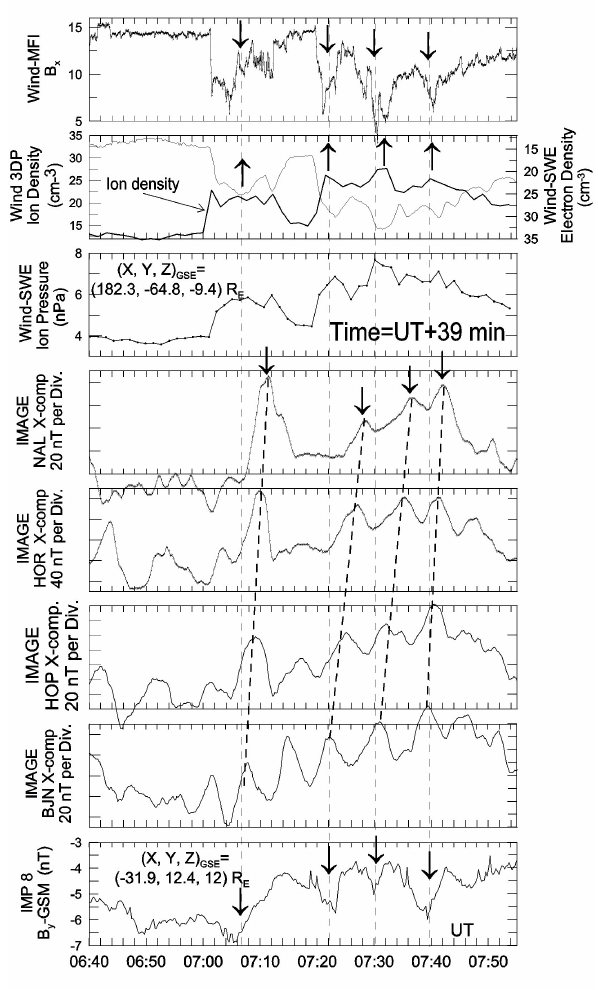
Fig. 8. From top to bottom, Wind/MFI magnetic field B x compo- nent, Wind/3DP ion density (thick line) and Wind/SWE electron density (thin line, in descending scale), Wind/SWE ion pressure in nPa (third panel), NAL, HOR, HOP and BJN station X-component magnetograms, and the B y component of the magnetosphere mag- netic field as measured by IMP 8 (bottom